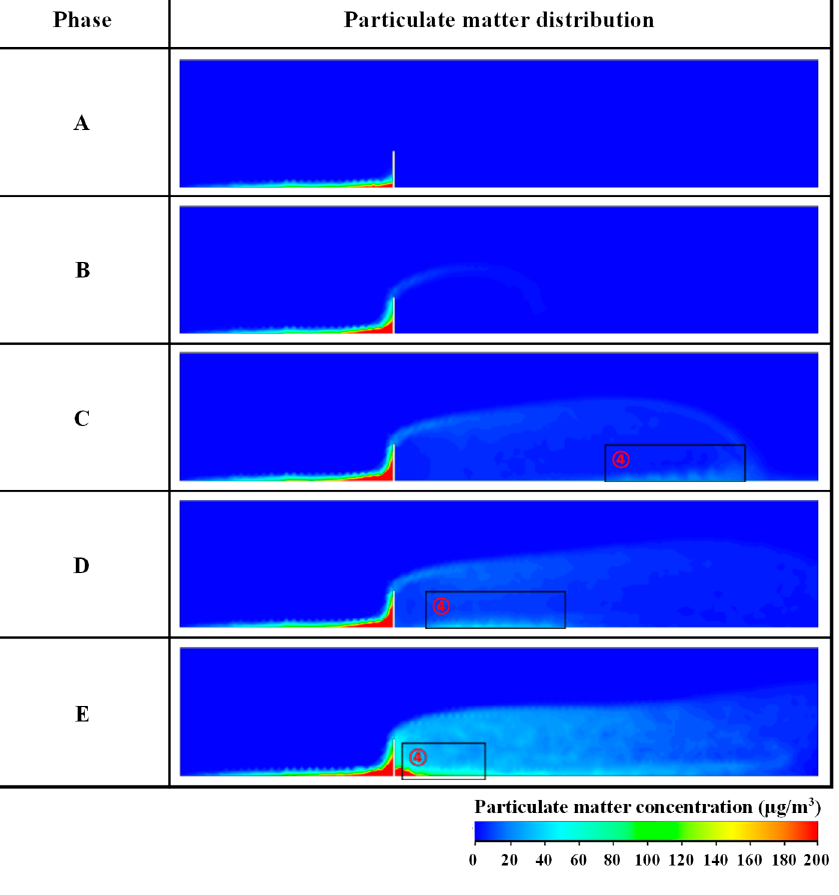
Figure 4. Distribution of particle mass concentration at different stages on monitoring section S when initial horizontal wind speed is 3 m/s and enclosure height is 3.5 m. ○ 4 is the reflux area of PM.